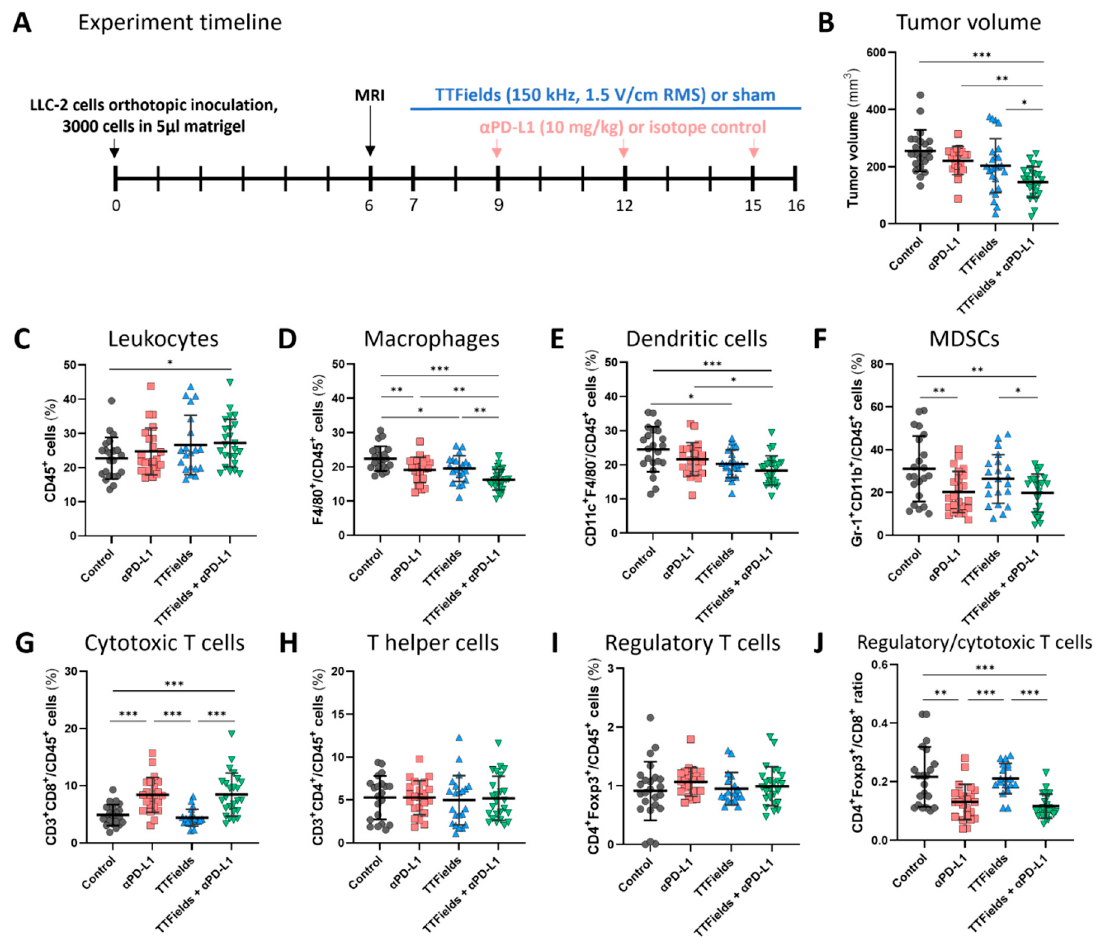
Figure 3. Concomitant TTFields with anti-PD-L1 reduced tumor volume and increased tumor infiltration of cytotoxic T cells. ( A ) Mice were orthotopically inoculated with LLC-2 Lewis lung carcinoma cells and treated according to the depicted timeline with: (1) isotype control, sham; (2) anti-PD-L1, sham; (3) isotype control, TTFields; or (4) anti-PD-L1, TTFields. ( B ) Tumor volumes were measured at treatment end. Tumors were further analyzed for the percentages of tumor leukocytes (CD45 + ) ( C ), macrophages (CD45 + CD11b + F4/80 + ) ( D ), dendritic cells (CD45 + CD11c + F4/80 – ) ( E ), myeloid-derived suppressor cells MDSCs (CD45 + Gr-1 + CD11b + ) ( F ), as well as cytotoxic (CD3 + CD8 + ) ( G ), helper (CD3 + CD4 + ) ( H ), and regulatory (CD4 + Foxp3 + ) ( I ) T cells, and the ratio of regulatory to cytotoxic T cells was calculated ( J ). MFI-median fluorescence intensity. Three independent experiments are shown. n = 14–17 mice per group. Values are mean ± SD. * p < 0.05, ** p < 0.01, and *** p < 0.001; one-way ANOVA followed by Tukey’s multiple comparisons for tumor volume; Student’s t -test for flow cytometry immunophenotyping.